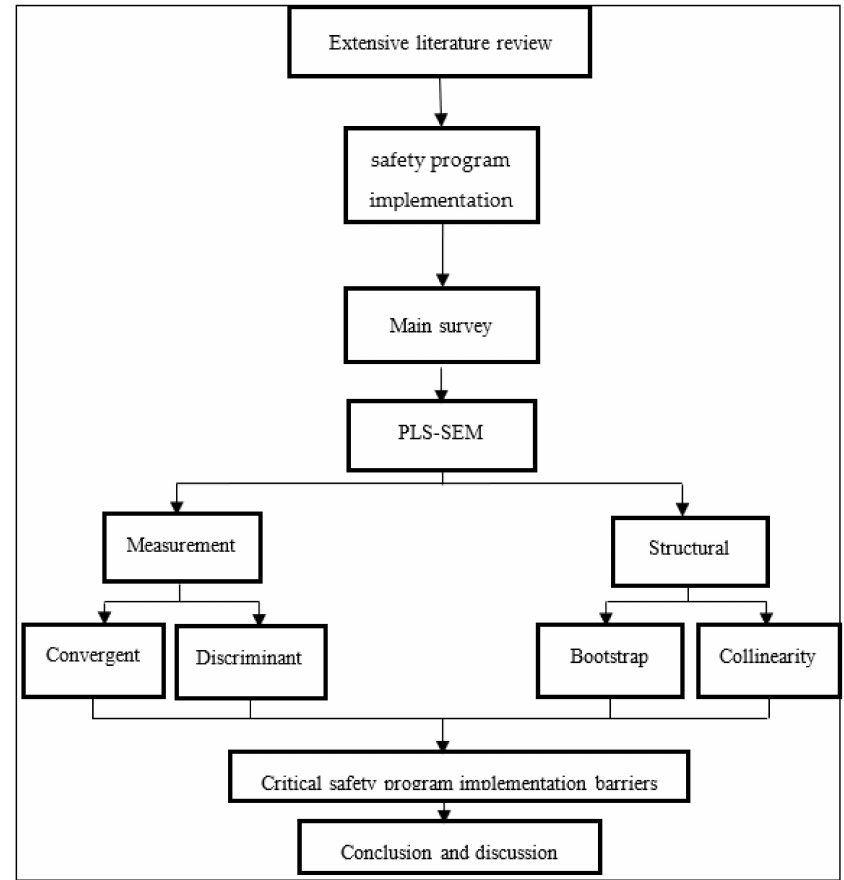
Figure 2. Research